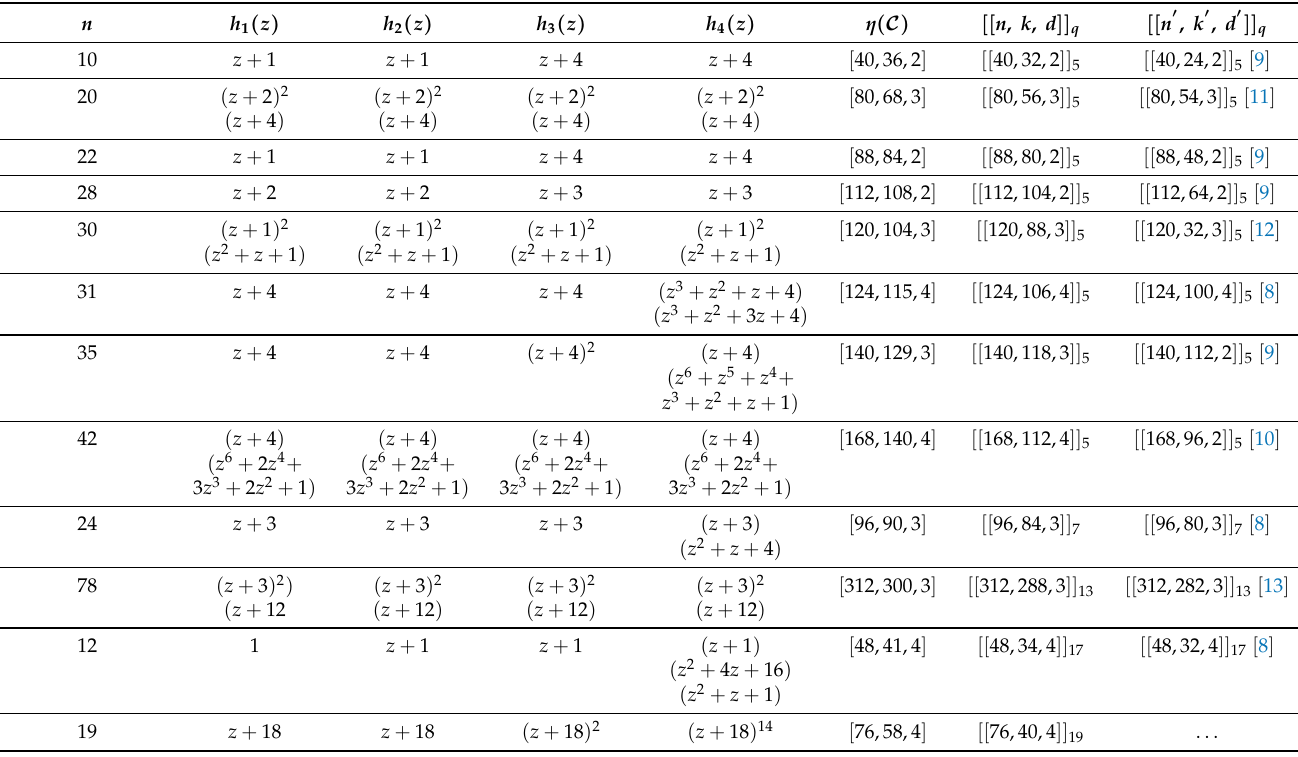
Table 1. Quantum codes from cyclic codes over R .